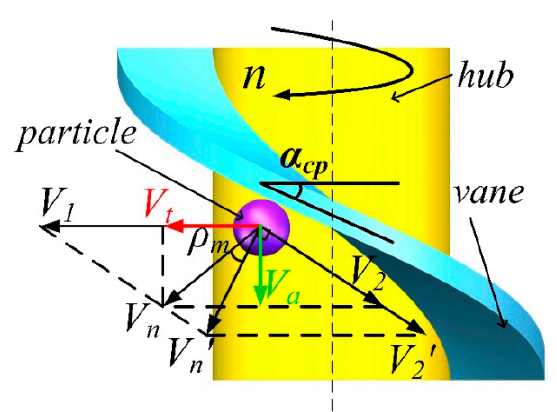
Figure 2. The kinematic analysis of a single particle under the action of the